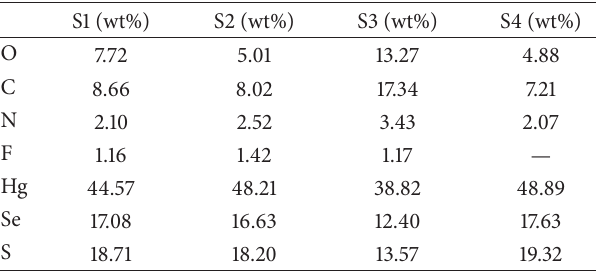
Table 3: Element contents in Zuota samples. The data were obtained from XPS and expressed as percentage of